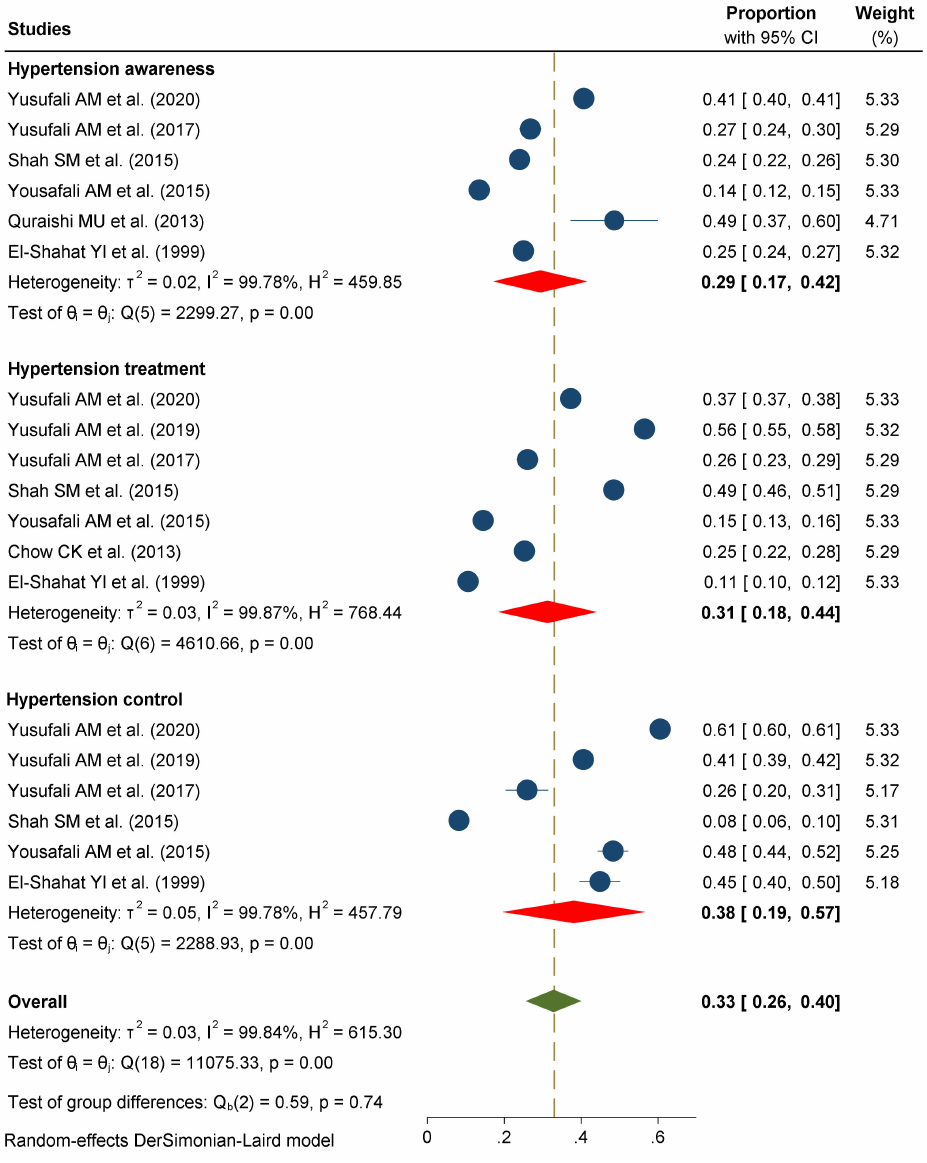
Figure 3. Hypertension awareness, treatment, and control in the United Arab